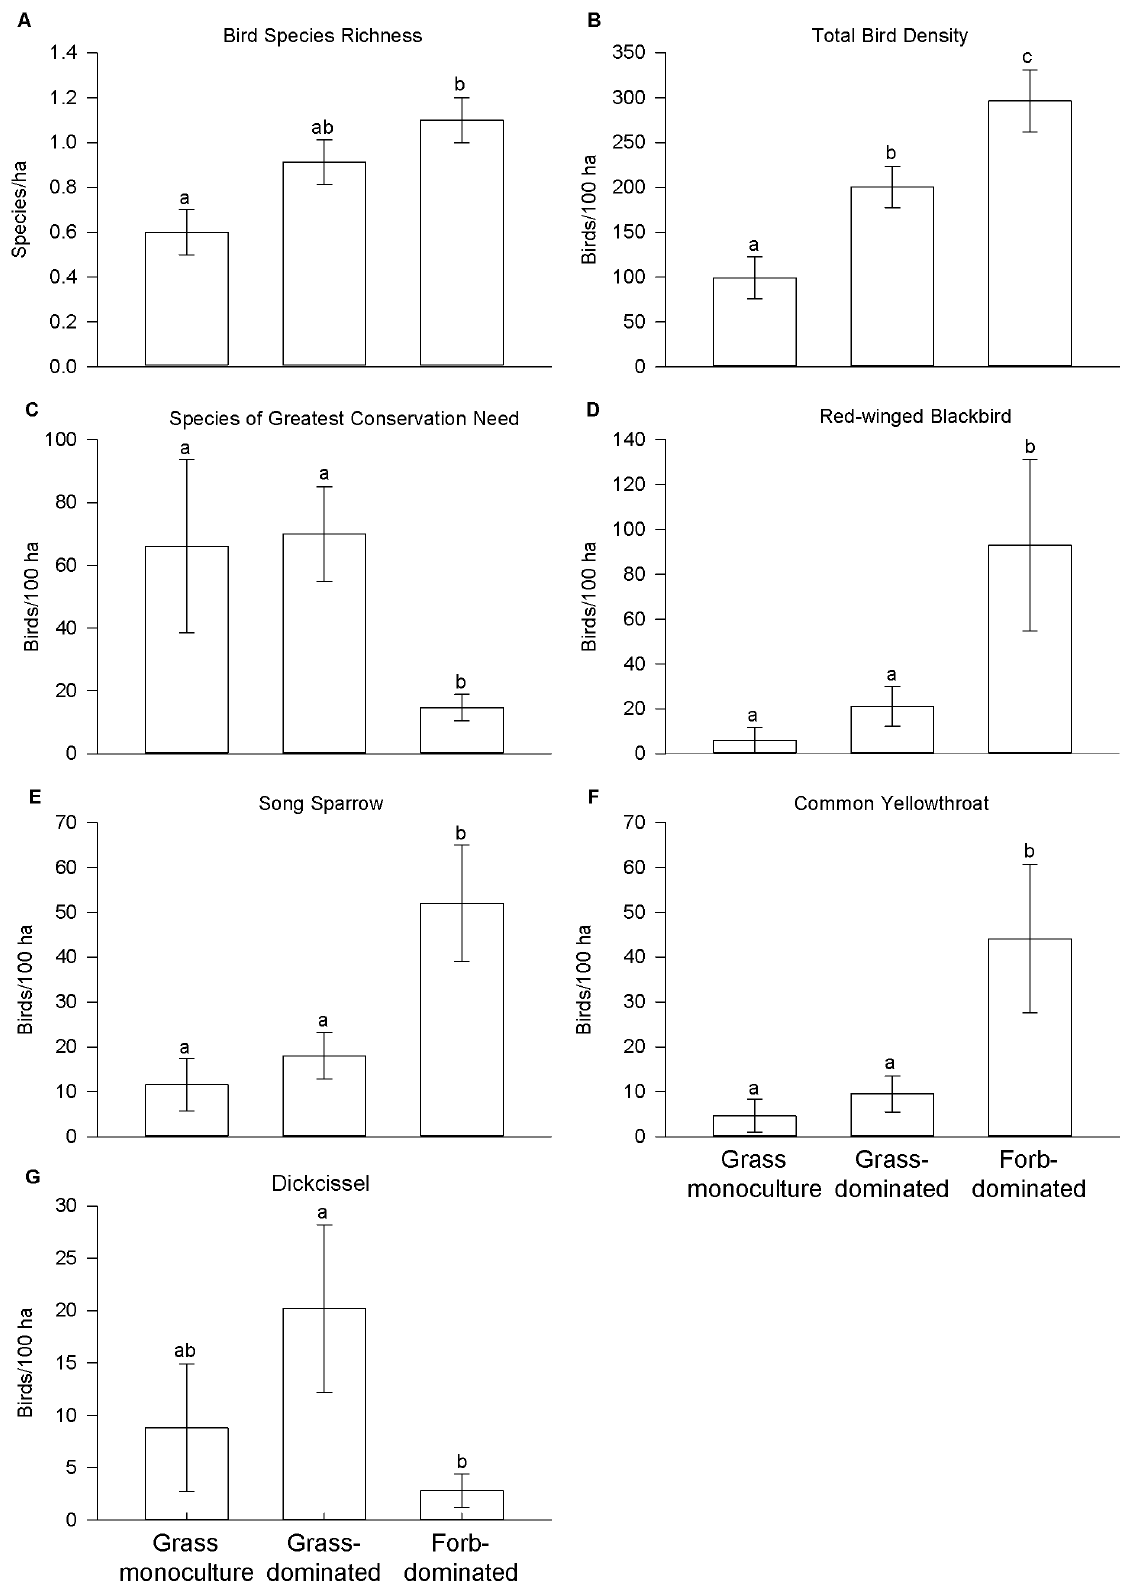
Figure 2. Predicted means of bird metrics in the three grassland field types. Error bars are 6 1 SE. Bars with the same letter above them are not significantly different.